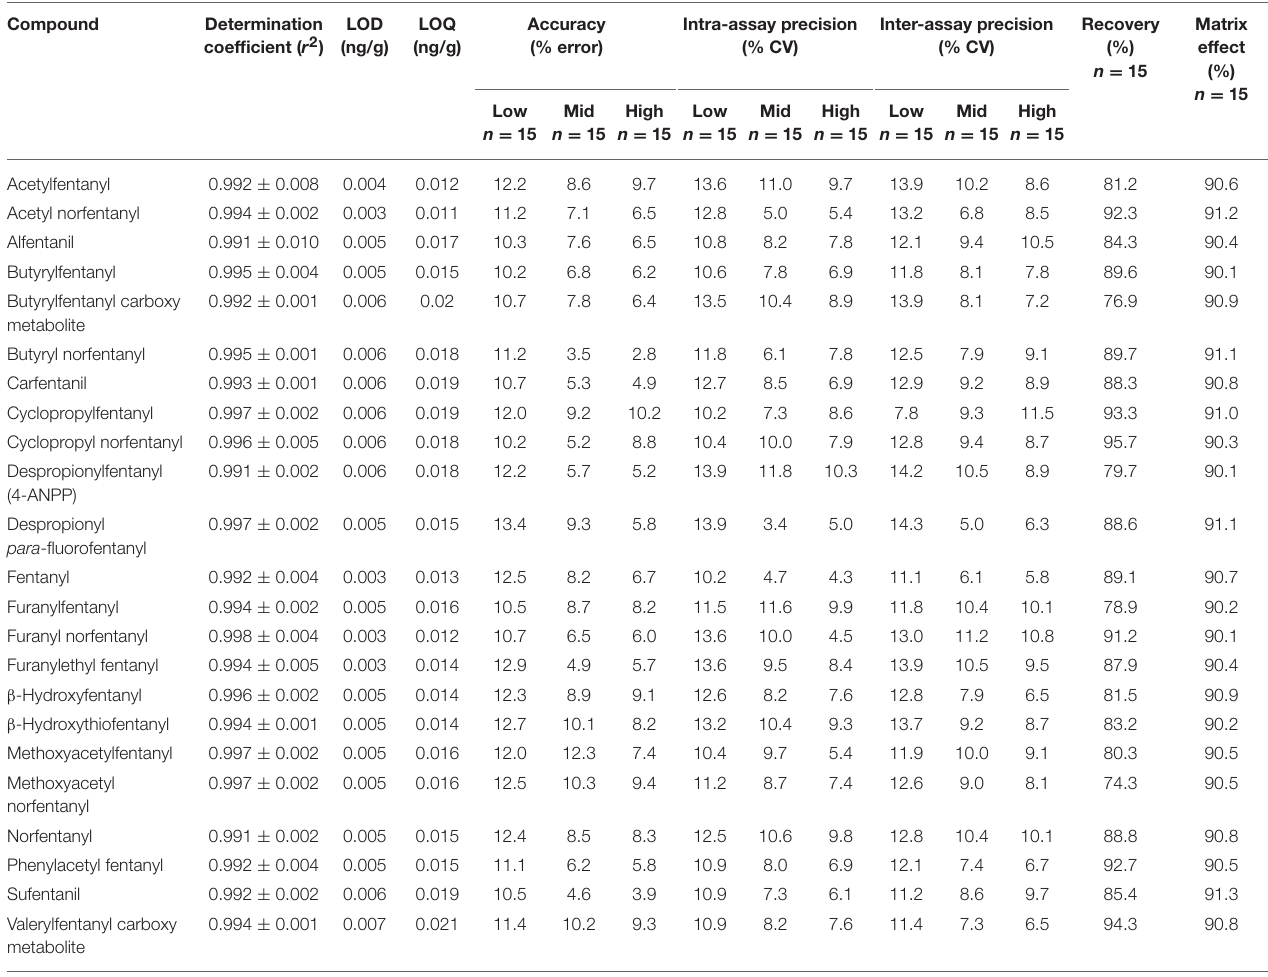
TABLE 4 | Validation parameters for fentanyl and analogs in hair.